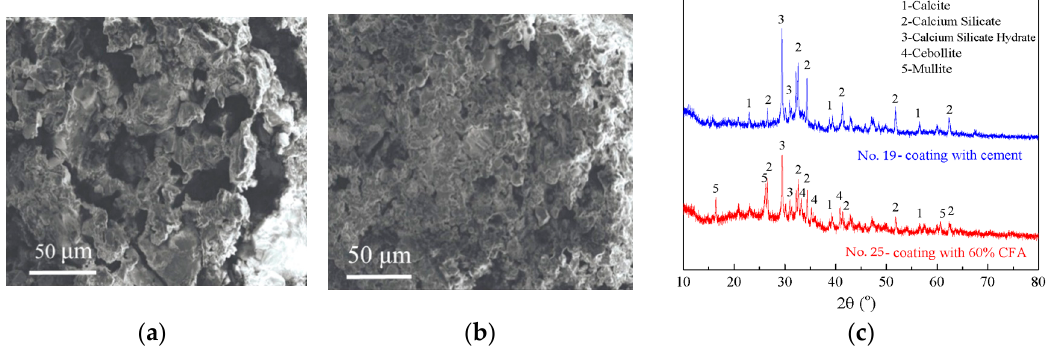
Figure 6. Comparison of SEM graphs of coating specimens ( a ) No. 19 and ( b ) No. 25, and ( c ) XRD patterns of different coating specimens.